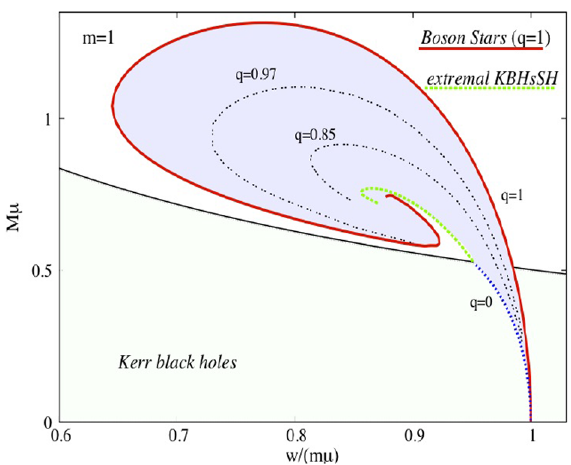
Fig. 11 Domain of existence for hairy black holes. The ADM mass of the solutions versus the oscillation frequency of the scalar field frequency. Solutions for a range of values of q interpolating between Kerr ( q = 0) and BSs ( q = 1) all with azimuthal quantum number m = 1. For 0 < q < 1, solutions describe rotating BHs surrounded by a scalar cloud, constituting scalar hair for the BH. Reprinted with permission from Herdeiro and Radu (2015a); copyright by